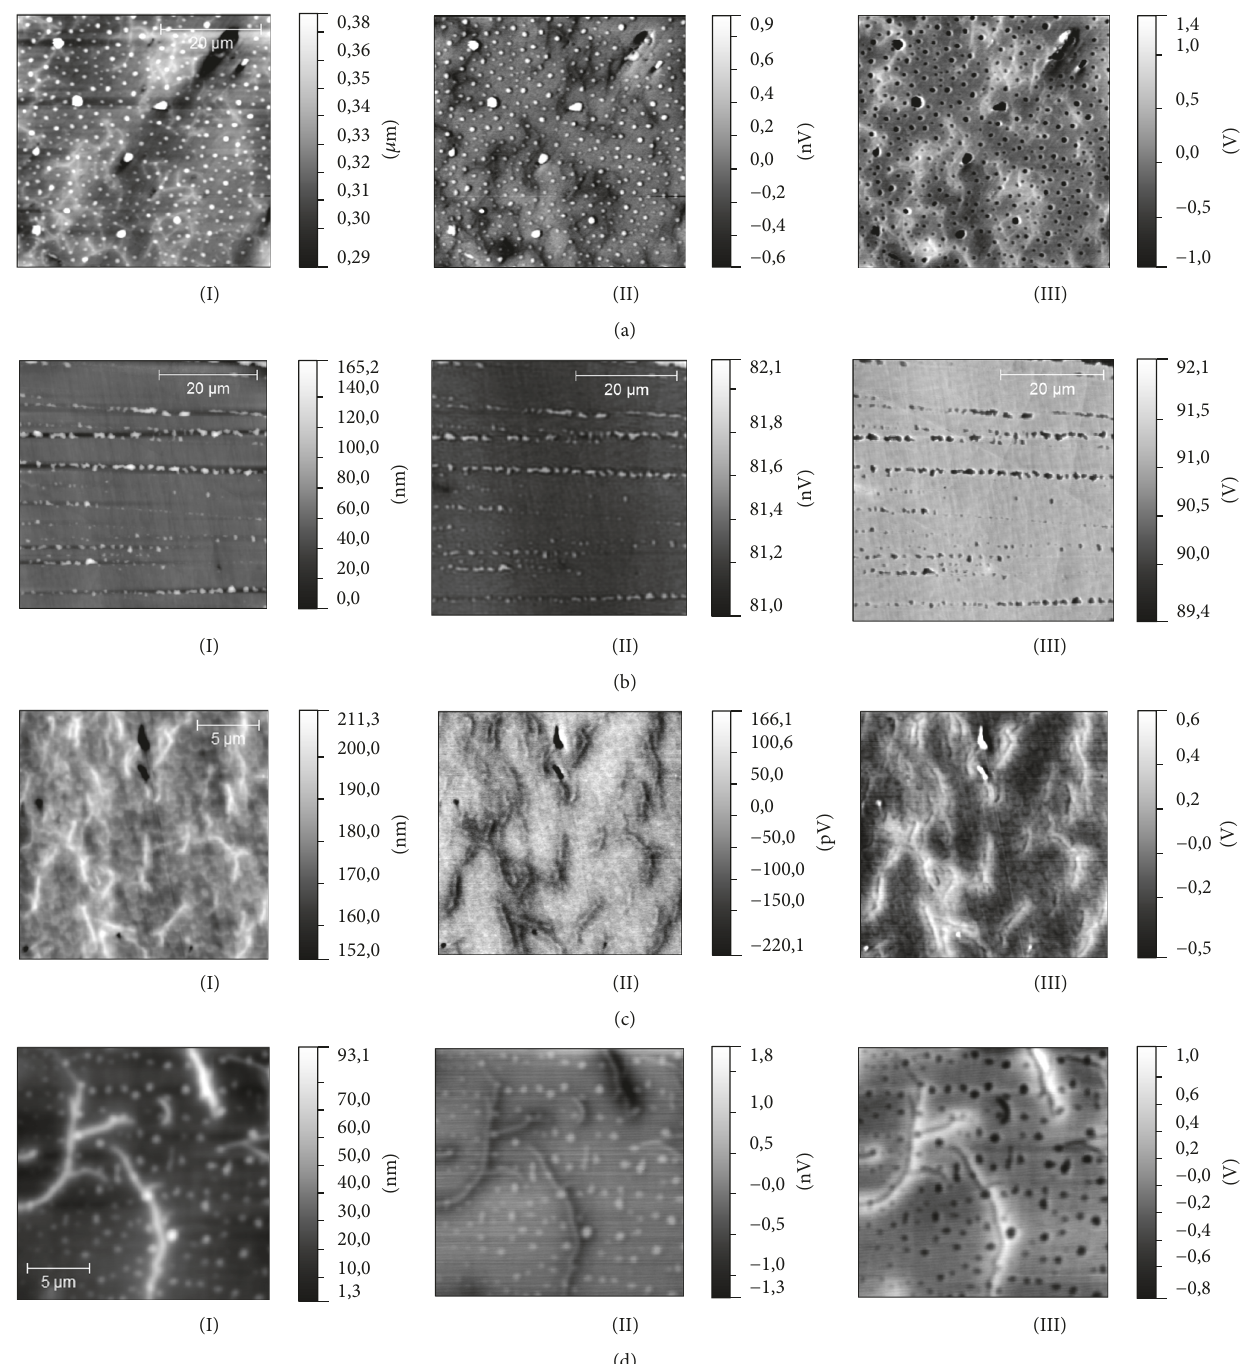
Figure 7: The results of MFM measurements: (I) topography of the samples, (II) MFM amplitude, and (III) MFM phase. (a) S2 sample, (b) S1 sample, (c) S3 sample, and (d) S4